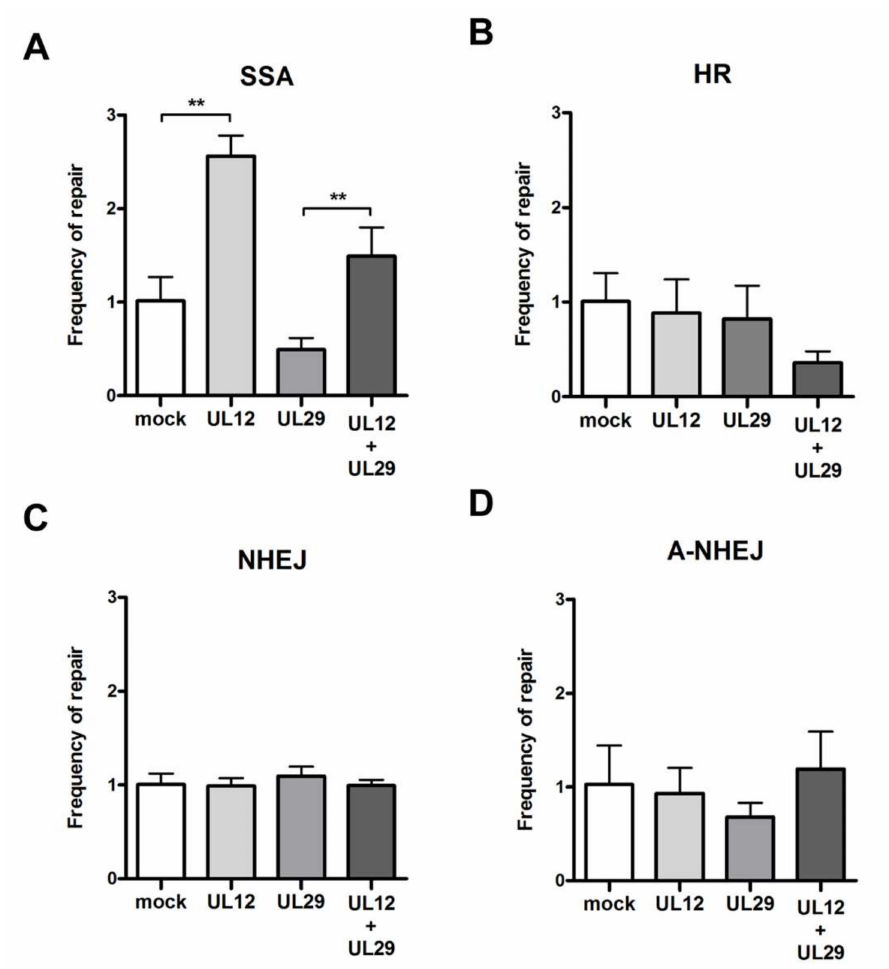
Figure 3. Role of UL12 and UL29 in DNA damage repair. Four DNA damage reporter cell lines were utilized, containing an integrated DNA damage reporter that expresses GFP when an induced dsDNA break is repaired by ( A ) single strand annealing (SSA), ( B ) homologous recombination (HR), ( C ) non-homologous end joining (NHEJ), and ( D ) alternative NHEJ (A-NHEJ). These cell lines were transfected with expression plasmids for UL12 and/or UL29, to assess whether these MDV proteins can aid in the specific DNA repair pathways. The mean frequency of repair for the indicated expression constructs is shown from six independent experiments ± SEM. Statistics were performed using the Mann–Whitney U test **, p <